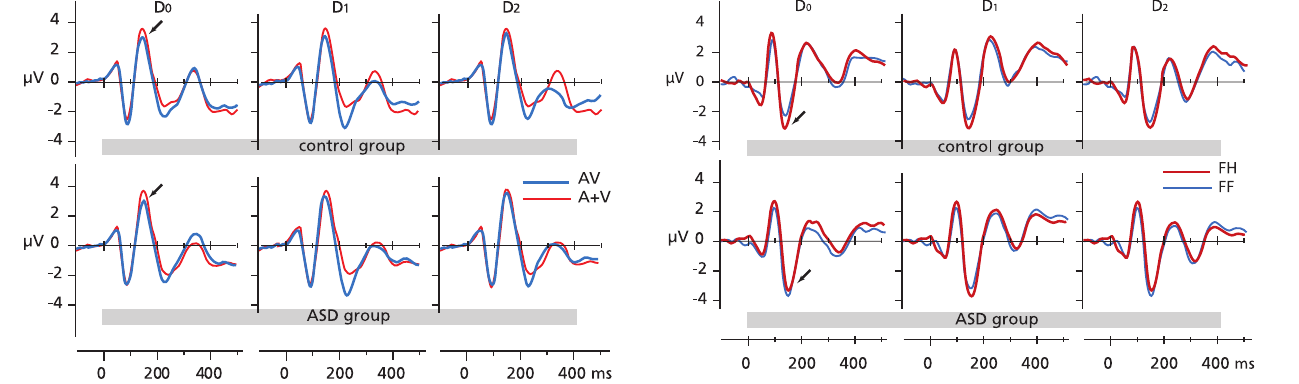
Figure 2. Frontal-central P2 amplitudes. Frontal-central P2 peaks are significantly larger (p , .001) to the sum of ERPs to unisensory stimuli (A + V) than to cross-modal (AV) stimuli under divided attention (D 0 ) and easy selective attention conditions (D 1 ) for both groups.